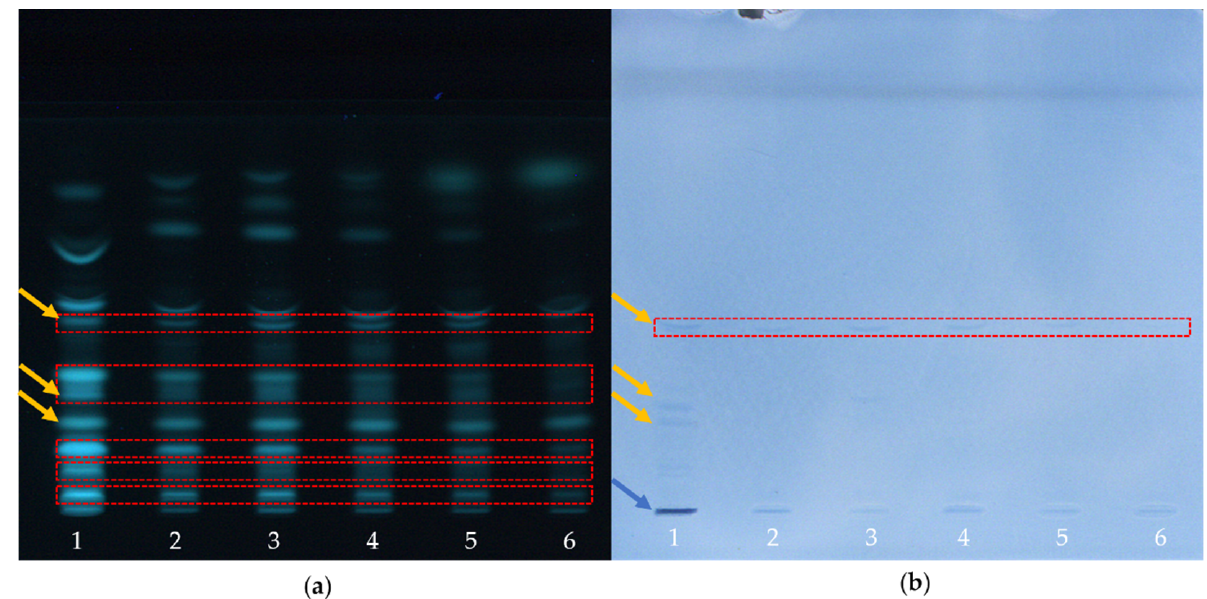
Figure 3. HPTLC analysis of tryptically digested α-LA derivatives as a function of BITC concentration. ( a ) Protein staining using fluorescamine as a derivation reagent (UV-light; λ = 366 nm), ( b ) Immunological staining (white light). (1) α-LA control (freshly prepared), (2) α-LA control (treated similar as BITC-protein derivatives), (3) BITC-α-LA derivative “low” (c BITC = 3.8 mM), (4) BITC-α-LA derivative “moderate” (c BITC = 38 mM), (5) BITC-α-LA derivative “high” (c BITC = 75 mM); (6) BITC-α-LA derivative “very high” (c BITC = 113 mM).